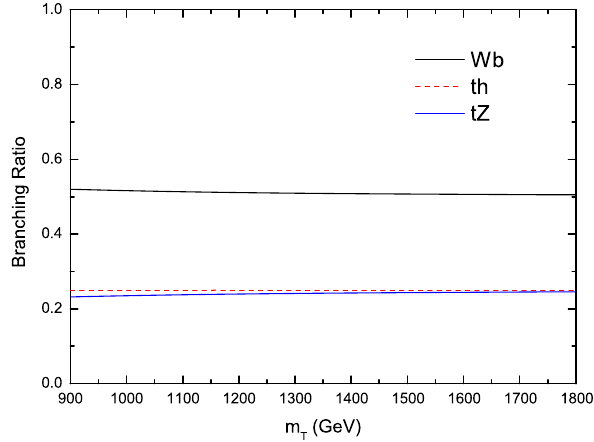
Fig. 1 Branching ratios for the three decay modes for various of top- partner masses with g ∗ = 0 . 2